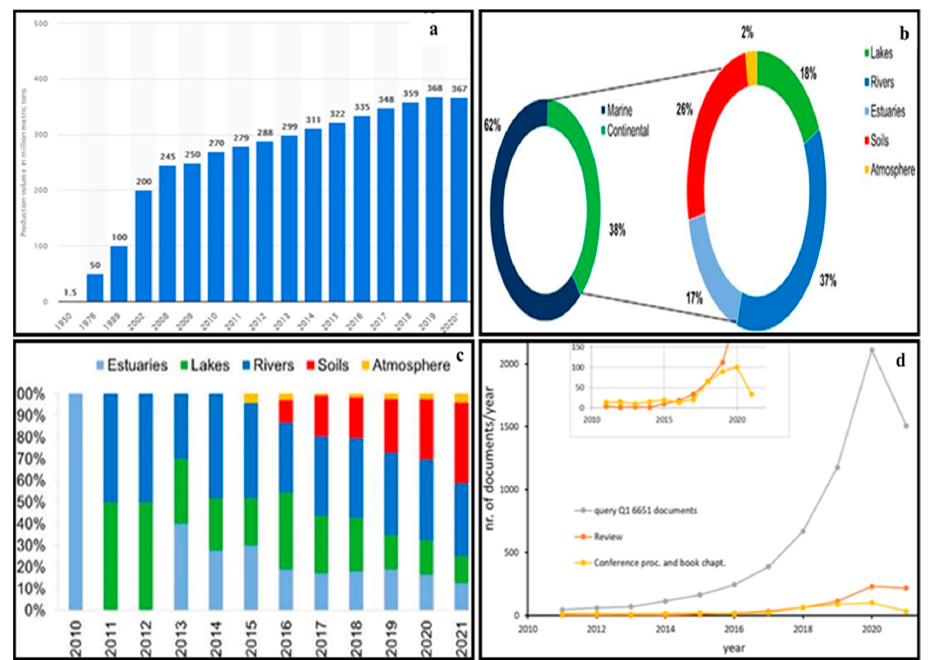
Figure 3. ( a ) The percentage of microplastics studied in marine and continental environments, lakes, rivers, estuaries, soils, and the atmosphere. ( b ) An analysis of European plastics production. ( c ) Percentage of studies in each type of continental environment per year. ( d ) The trend of the number of total documents, reviews or conference proceedings, and book chapters published from the year 2010 [5,12,17].